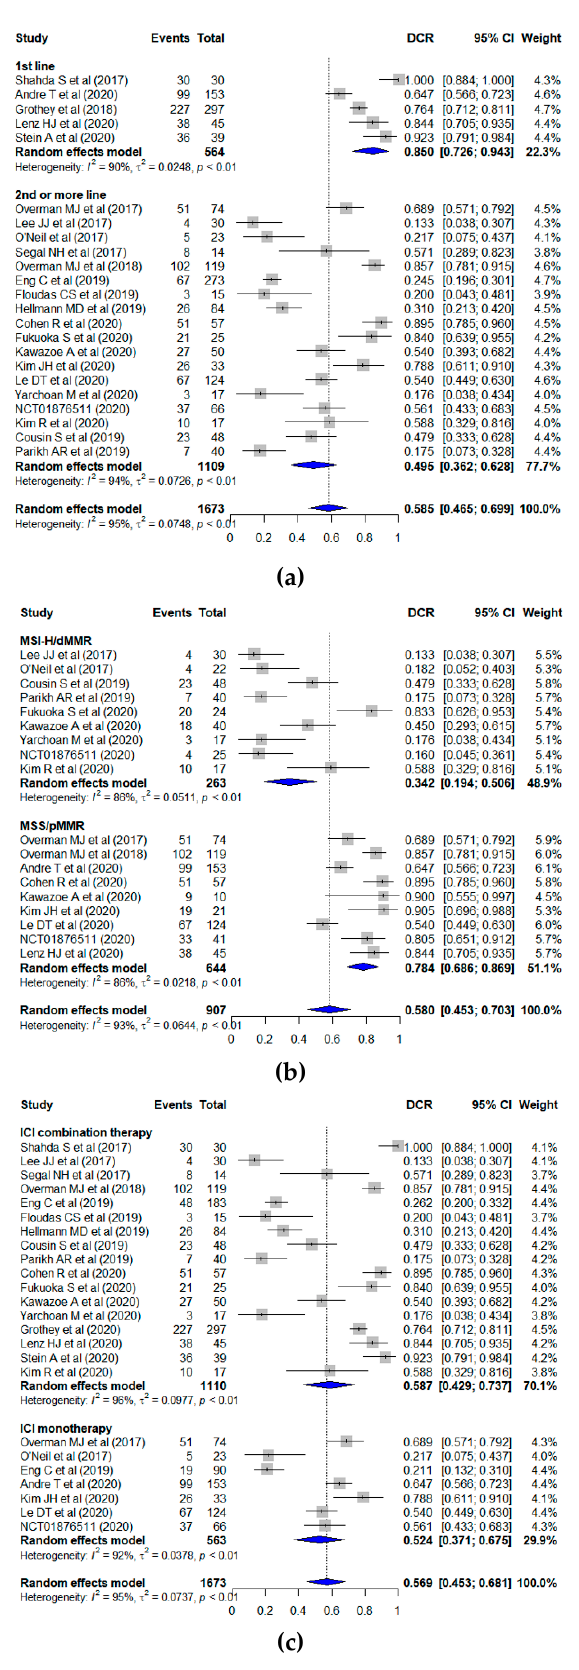
Figure 4. Forest plots displaying the pooled DCR according to ( a ) treatment line, ( b ) microsatellite phenotype, and ( c ) drug regimen.